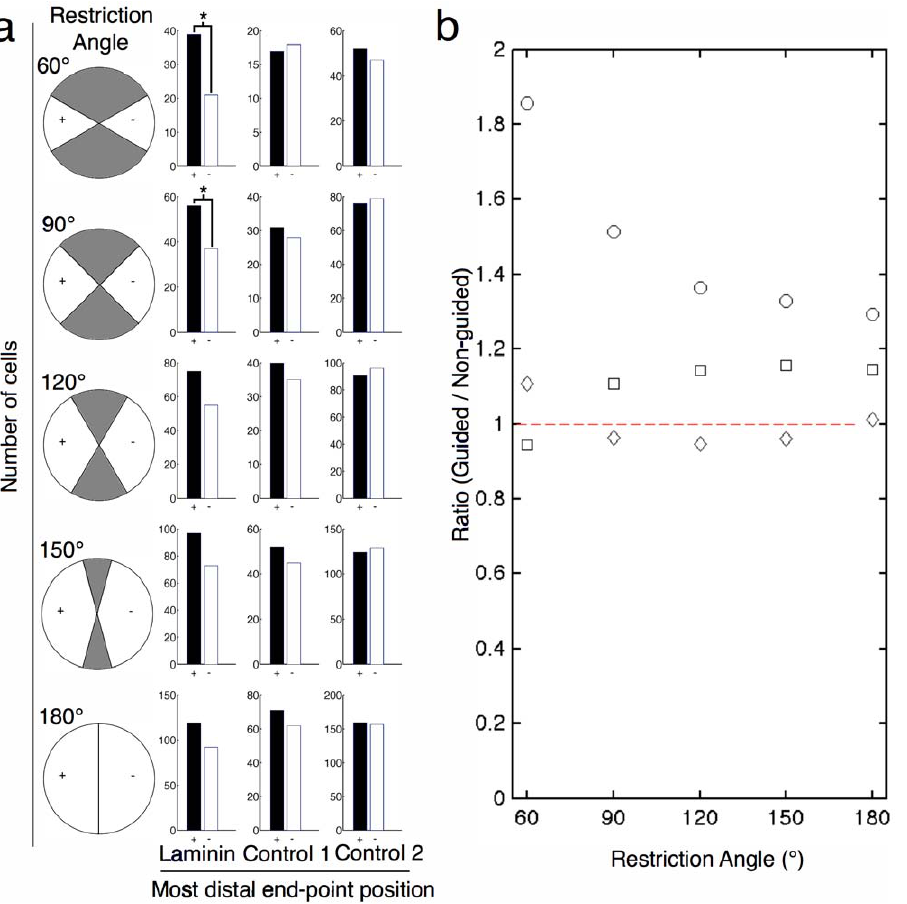
Figure 5. Effect of varying the restriction angle used to define whether an extending neurite was attracted or repusled by the gradient. (a) Histograms of the most distal end-point position for different restriction angle. (b) Ratio of attracted over repulsed neurites shows how this arbitrary parameter can greatly influence the outcome of the analysis. (Circles=Laminin, Squares=Control 1, Diamonds=Control 2). This analysis demonstrates that high-content screens of neurite guidance are strongly dependent on choice of critical user-defined parameters. Data used from high-slope gradients, three hours after differentiation.